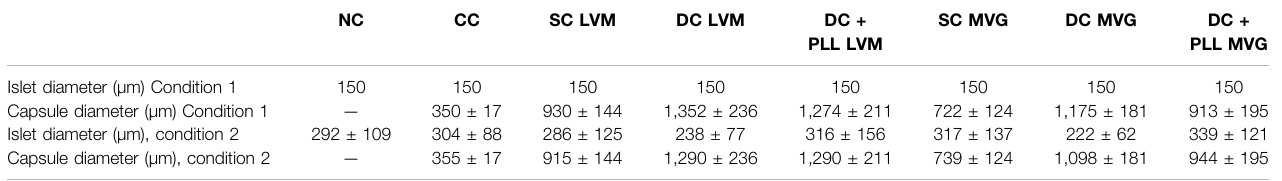
TABLE 4 | Standard (150 µm) islet diameter (condition 1) and diameters of islets obtained through ImageJ quanti fi cation (condition 2) and capsule diameters obtained through ImageJ used for the present COMSOL Multiphysics simulations. Values shown as mean ± SD.